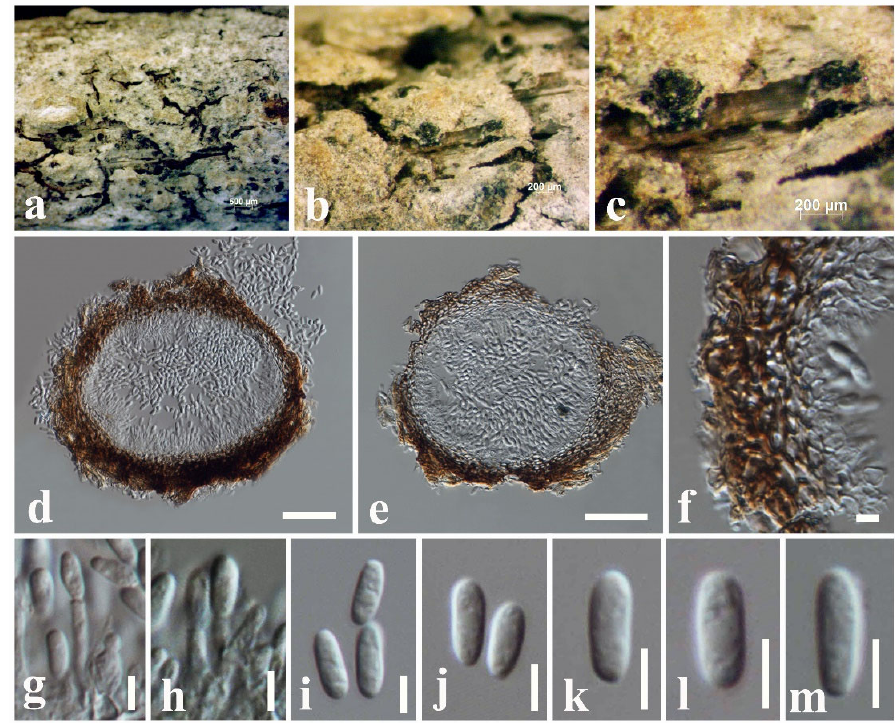
Figure 8. Neobambusicola magnoliae (HKAS 107122, holotype). ( a – c ) Appearance of conidiomata on substrate. ( d , e ) Vertical sections through conidiomata. ( f ) Conidiomatal wall. ( g , h ) Conidiogenous cells and developing conidia. ( i – m ) Conidia. Scale bars: ( c ) = 200 μ m, ( d , e ) = 20 μ m, ( f – m ) = 5 μ m.